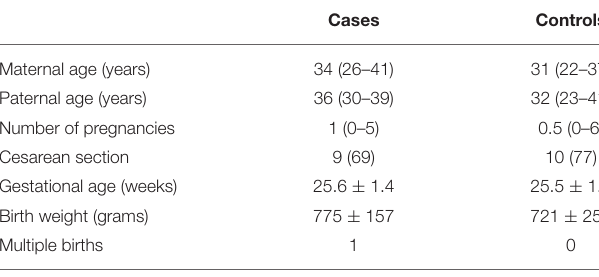
TABLE 1 | Comparison of perinatal data of 13 parents of an ELGAN having received information on ECI (cases) and 13 control parents (controls) without. Cases